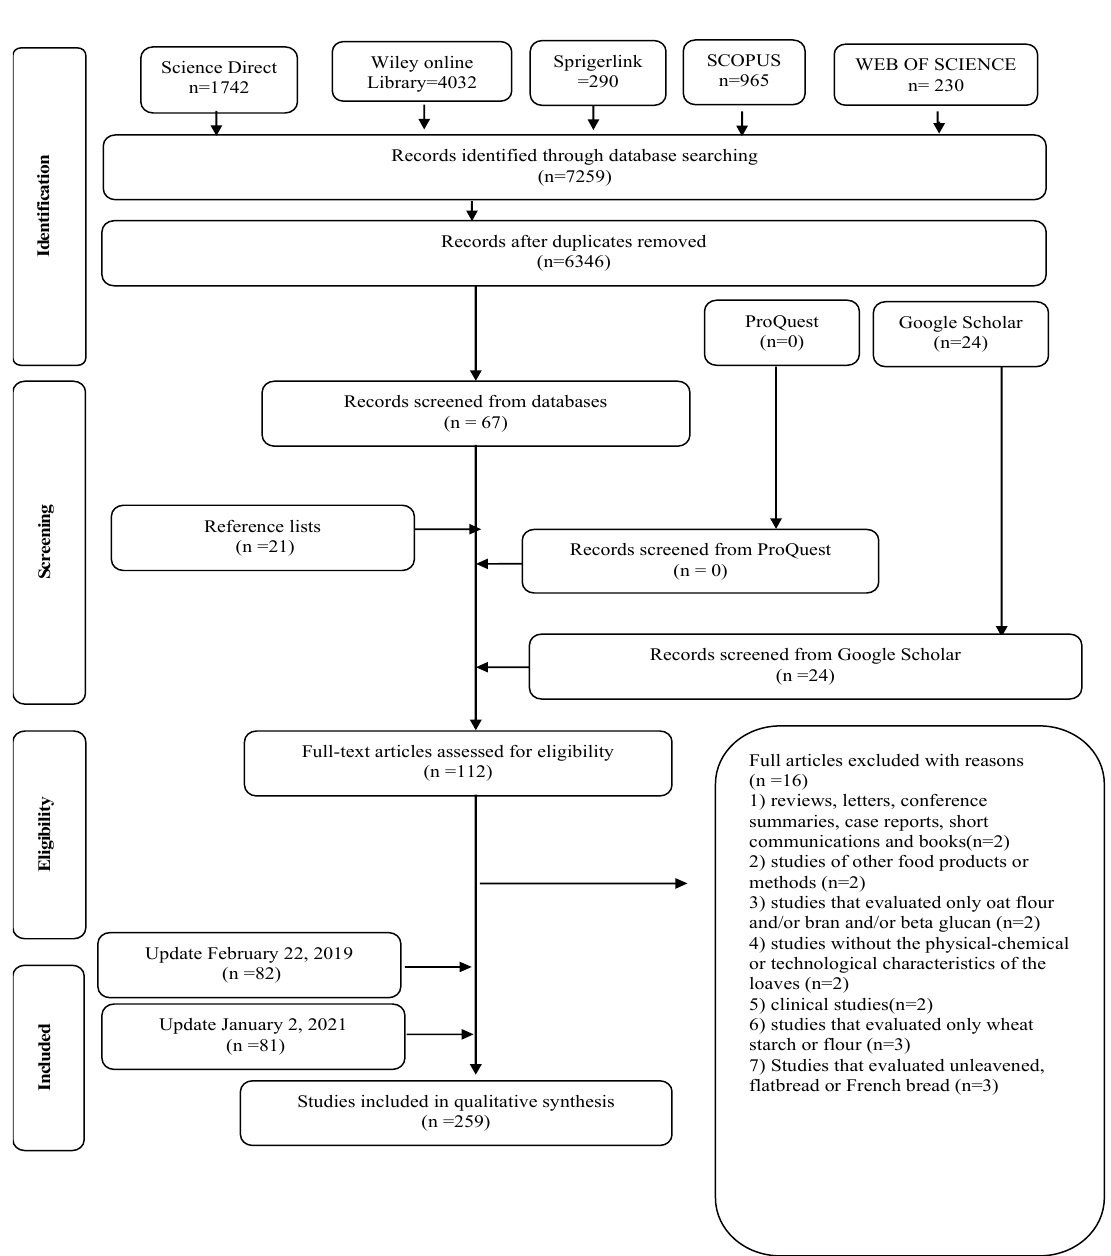
Figure 1. Flow diagram of literature search and selection criteria (Adapted from Preferred Reporting Items for Systematic Reviews and Meta-Analyses—PRISMA). Table 1. Extraction table containing references, starch sources, gluten substitutes, additives, water, specific volume, crumb and crust characteristics, and sensory analysis of gluten-free bread with specific volume above 3.5 cm 3/ g.